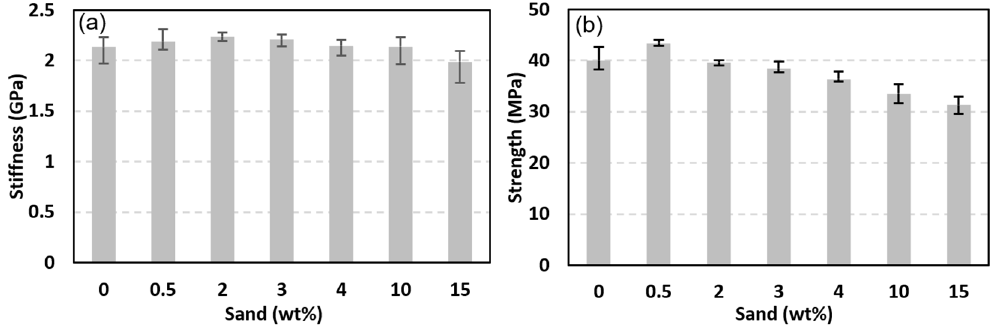
Figure 12. Effect of sand weight fraction on PLA-sand filaments’ stiffness ( a ) and strength ( b ).